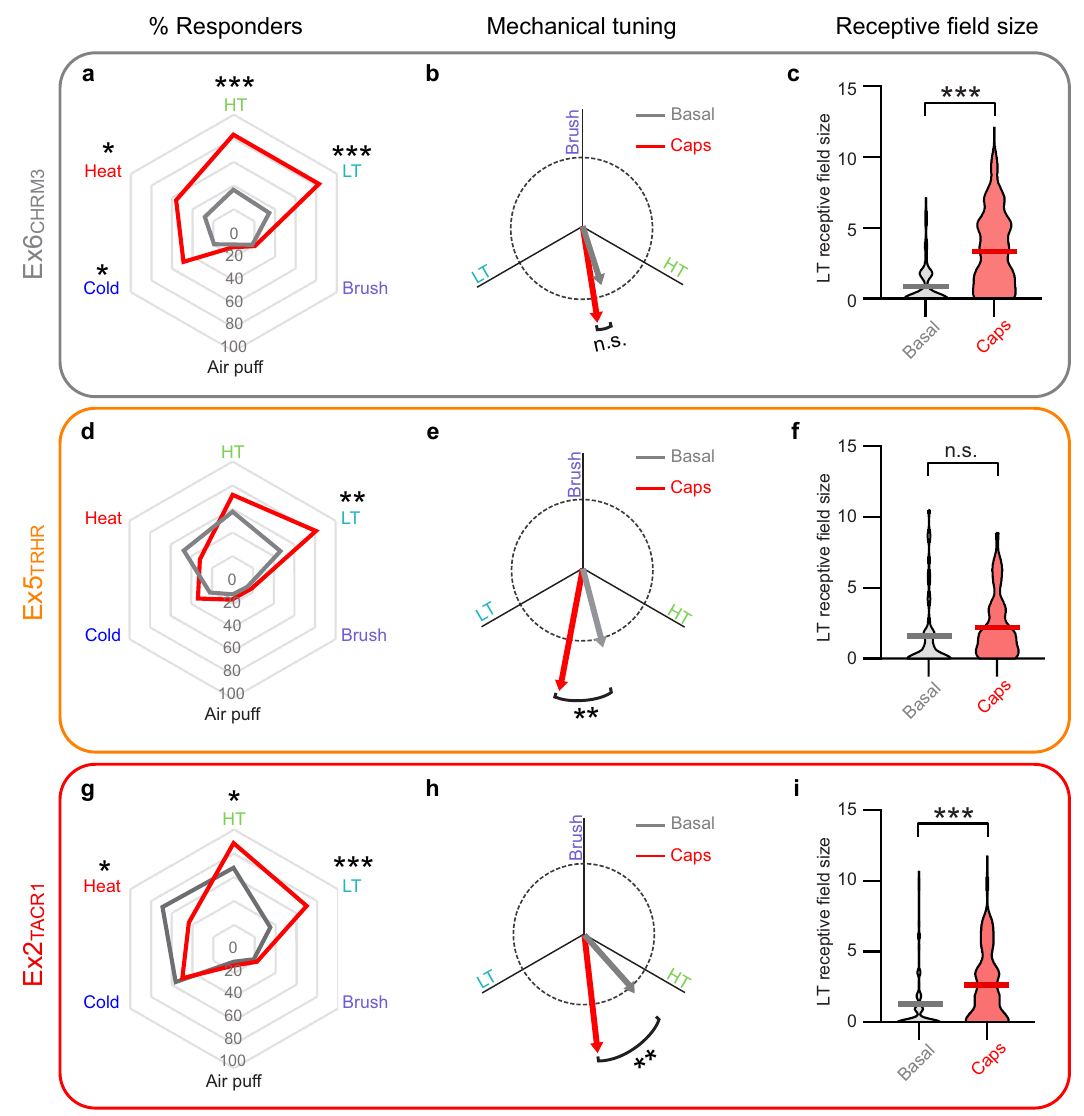
Fig. 7 | CICADA reveals distinct populations involved in central sensitization. Radar charts showing the percentof cellsin Ex6 CHRM3 a ,Ex5 TRHR d ,and Ex2 TACR1 g which responded to the indicated cutaneous stimuli before (grey) and after capsaicin injection (red). *Q<0.05, **Q<0.01, ***Q<0.001, for each population a Fisher ’ s exact test (# responses before and after capsaicin) with FDR correc- tion was performed for each modality, only signi fi cant results are indicated (Benjamini and Hochberg, 6 tests, exact Q values for all tests in source data). Mechanical sub-modality tuning for Ex6 CHRM3 ( b ), Ex5 TRHR ( e ), and Ex2 TACR1 ( h ) before (grey) and after capsaicin injection (red). Dotted circle is 1 unit vector in diameter. There was a signi fi cant main effect of capsaicin (F (1, 123) = 30.10),